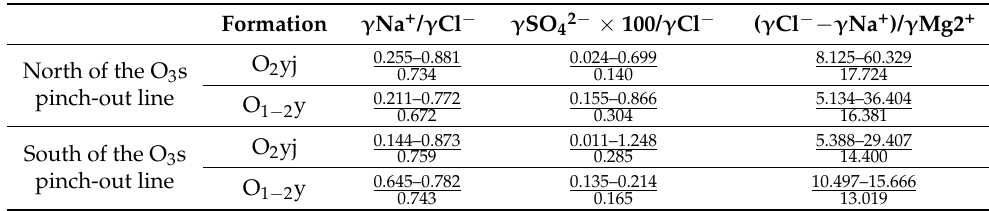
Figure 3. The distribution of TDS of Ordovician formation water in the Halahatang depression. The TDS is higher (basically above 200 g/L) in the North Region and gradually decreases to the south, but still greater than 50 g/L. Table 1. Ion-proportionality coefficients of Ordovician formation water in the Halahatang depression. The ion-proportionality coefficients of Ordovician formation water in the Halahatang depression show similar characteristics in both the North region and South